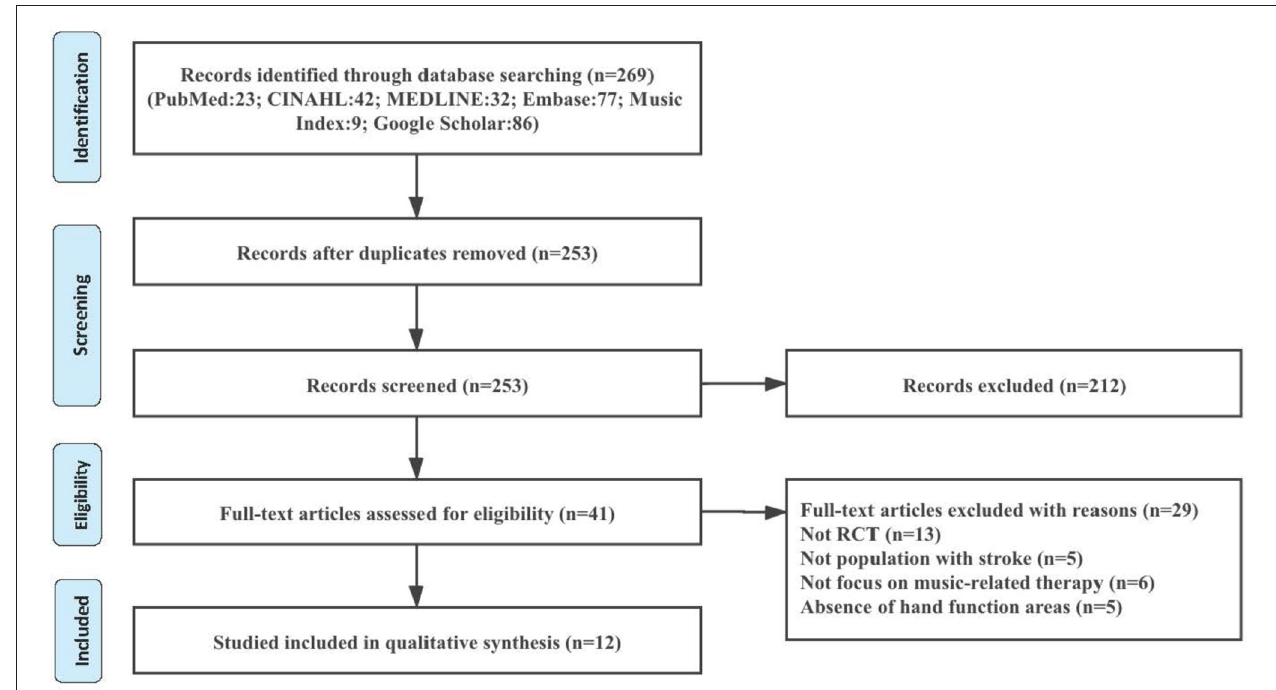
FIGURE 1 | A summary of the PRISMA flow of the study selection process.